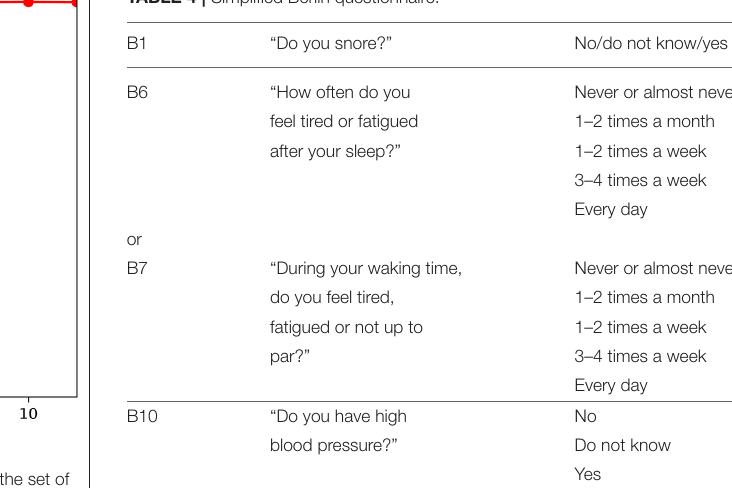
FIGURE 1 | Functional dependence of AUROC on the cardinality of the set of selected features.